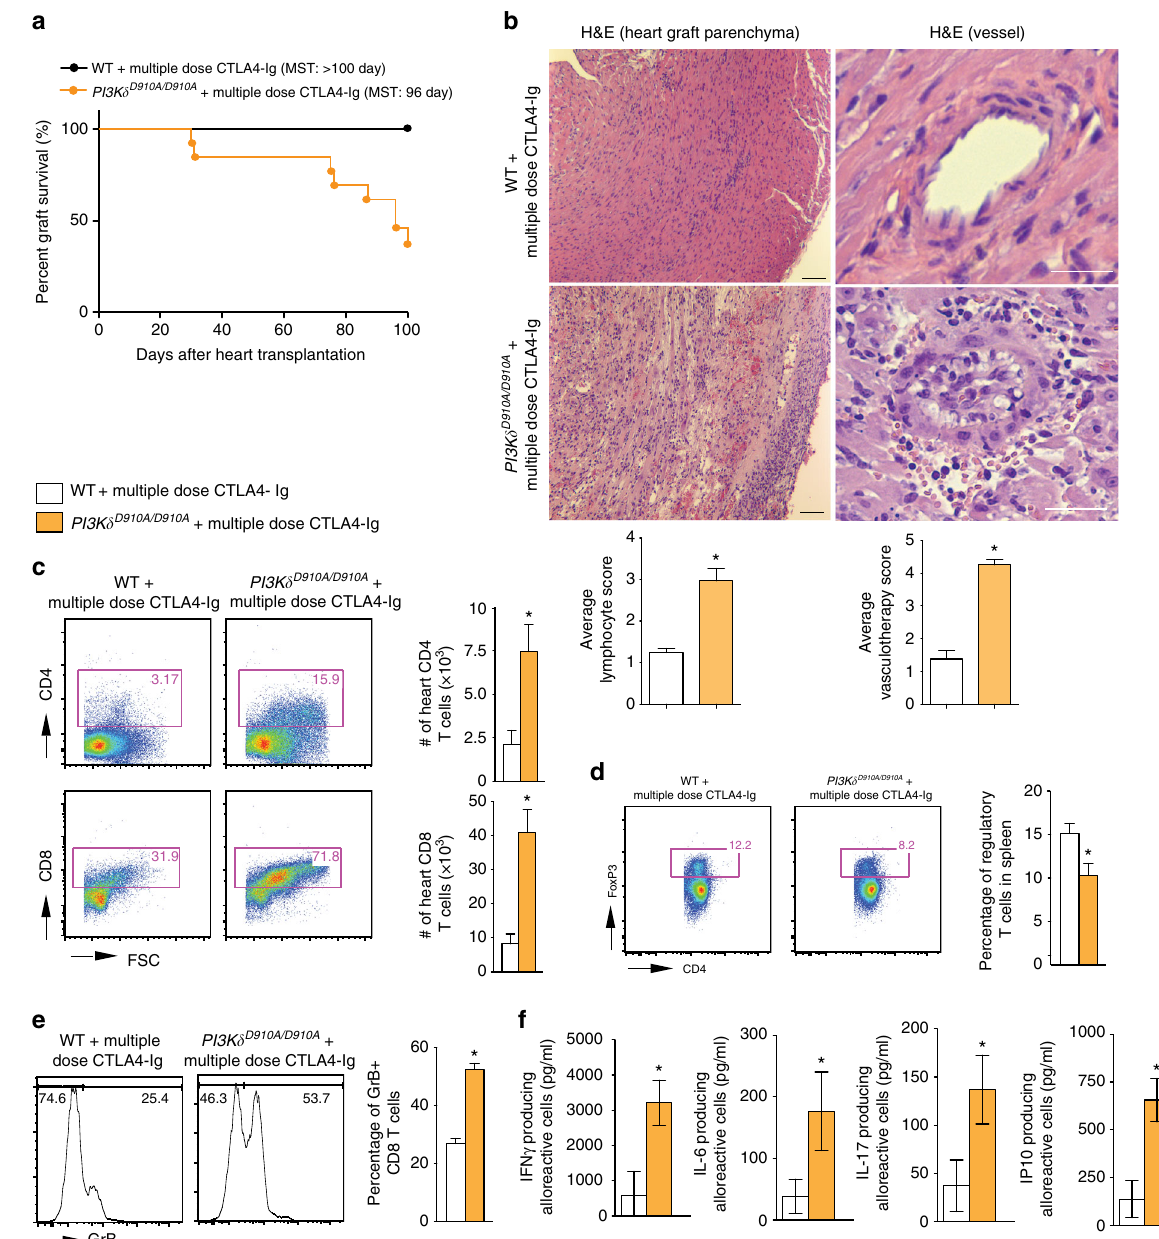
Fig. 4 PI3K δ deletion abrogates the tolerogenic effect of CTLA4-Ig. a Multiple dose CTLA4-Ig treatment of PI3K δ D910A/D910A recipients abrogates the long- term acceptance of fully mismatched BALB/c cardiac allografts seen in treated WT controls (MST of > 100 vs. 96 days, * p < 0.05, t -test, n = 10/group). b Representative examples of cardiac allograft histology harvested 100 days after transplant show higher grades of cellular in fi ltration (H&E stain, scale bar 50 μ m) and vasculopathy (H&E stain, scale bar 25 μ m) in the PI3K δ D910A/D910A hearts treated with multiple dose CTLA4-Ig compared to WT mice treated with multiple dose CTLA4-Ig ( n = 4/group). The bar graphs show the average of lymphocyte in fi ltration score and vasculopathy score. The PI3K δ D910A/D910A hearts treated with multiple dose CTLA4-Ig shows signi fi cantly higher score compared to WT mice treated with multiple dose CTLA4-Ig (* p < 0.05, t -test, n = 4/group, the graphs show data as mean ± s.e.m.). c Representative examples of dot plots of leukocytes isolated from the allograft of PI3K δ D910A/D910A and WT recipients treated with multiple dose CTLA4-Ig shows more CD4 + and CD8 + in fi ltration in the allografts of PI3K δ D910A/D910A recipients compared to WT control. Graph represents the absolute count of graft-in fi ltrating CD4 and CD8 in PI3K δ D910A/D910A recipients treated with multiple dose CTLA4-Ig compared to WT control treated with multiple dose CTLA4-Ig (* p < 0.05, t -test, n = 6/group). d Representative examples of dot plots of Tregs in the DLN of PI3K δ D910A/D910A and WT recipients treated with multiple dose CTLA4-Ig show signi fi cantly fewer Tregs in the PI3K δ D910A/ D910A recipients compared to WT control (* p < 0.05, t -test, n = 6/group). e Representative examples of histograms of GrB expression by CD8 + CD44 high T cells in the spleen of PI3K δ D910A/D910A and WT recipients treated with multiple dose CTLA4-Ig show signi fi cantly more GrB expression in CD8 + of the PI3K δ D910A/D910A recipients compared to WT (* p < 0.05, t -test, n = 4/group). f WT and PI3K δ D910A/D910A recipient splenocytes were stimulated with donor splenocytes. Bar graphs represent the level of IFN γ , IL-6, IL-17, and IP10 in the supernatant collected from the MLR assay as measured by luminex (* p < 0.05, t -test, n = 4/group). c – f The graphs show data as mean ± s.e.m. (MST mean survival time; DLN draining lymph node; Treg regulatory T